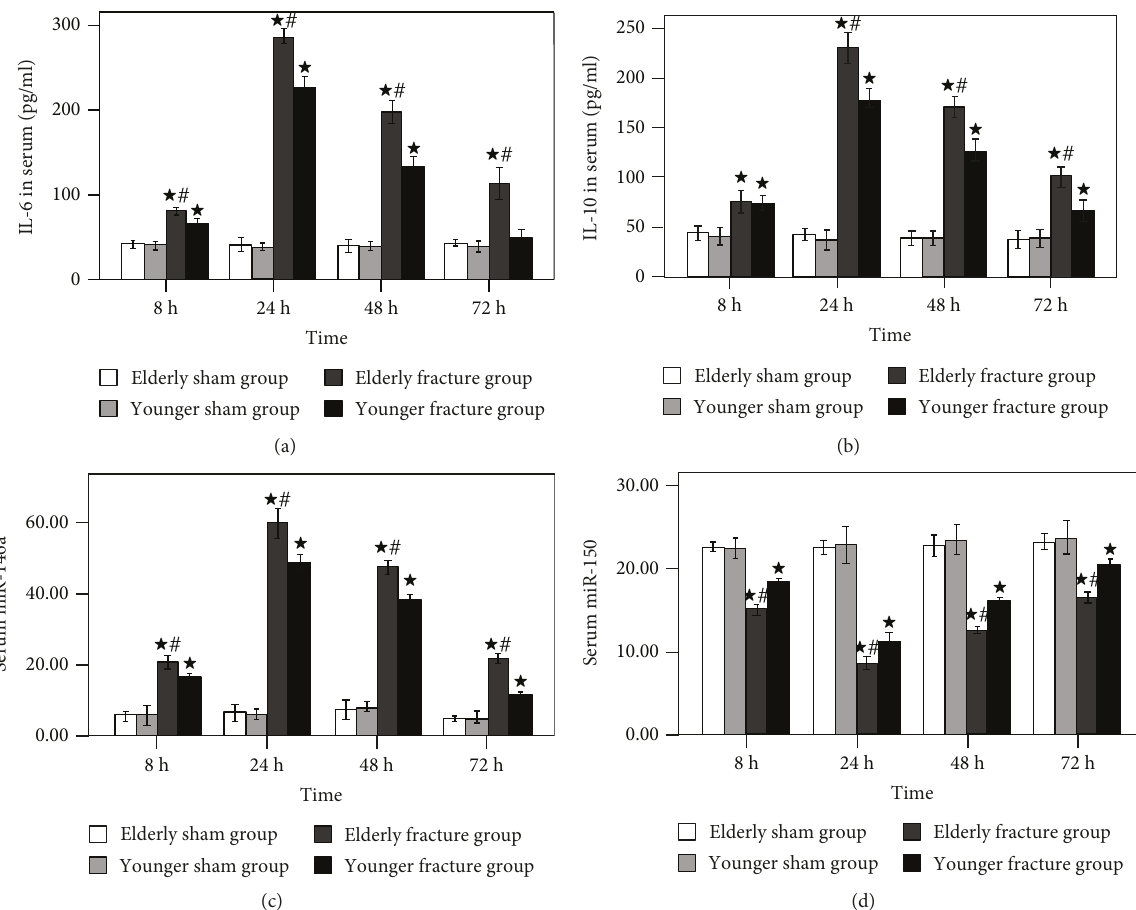
Figure 1: Time course of serum IL-6 (a), IL-10 (b), miRNA-146a (c), and miRNA-150 (d) levels. Results are expressed as mean ± standard error. Filled star: P < 0 05 for the elderly fracture group versus the elderly sham group and the younger fracture group versus the younger sham group. Pound sign: P < 0 05 for the elderly fracture group versus the younger fracture